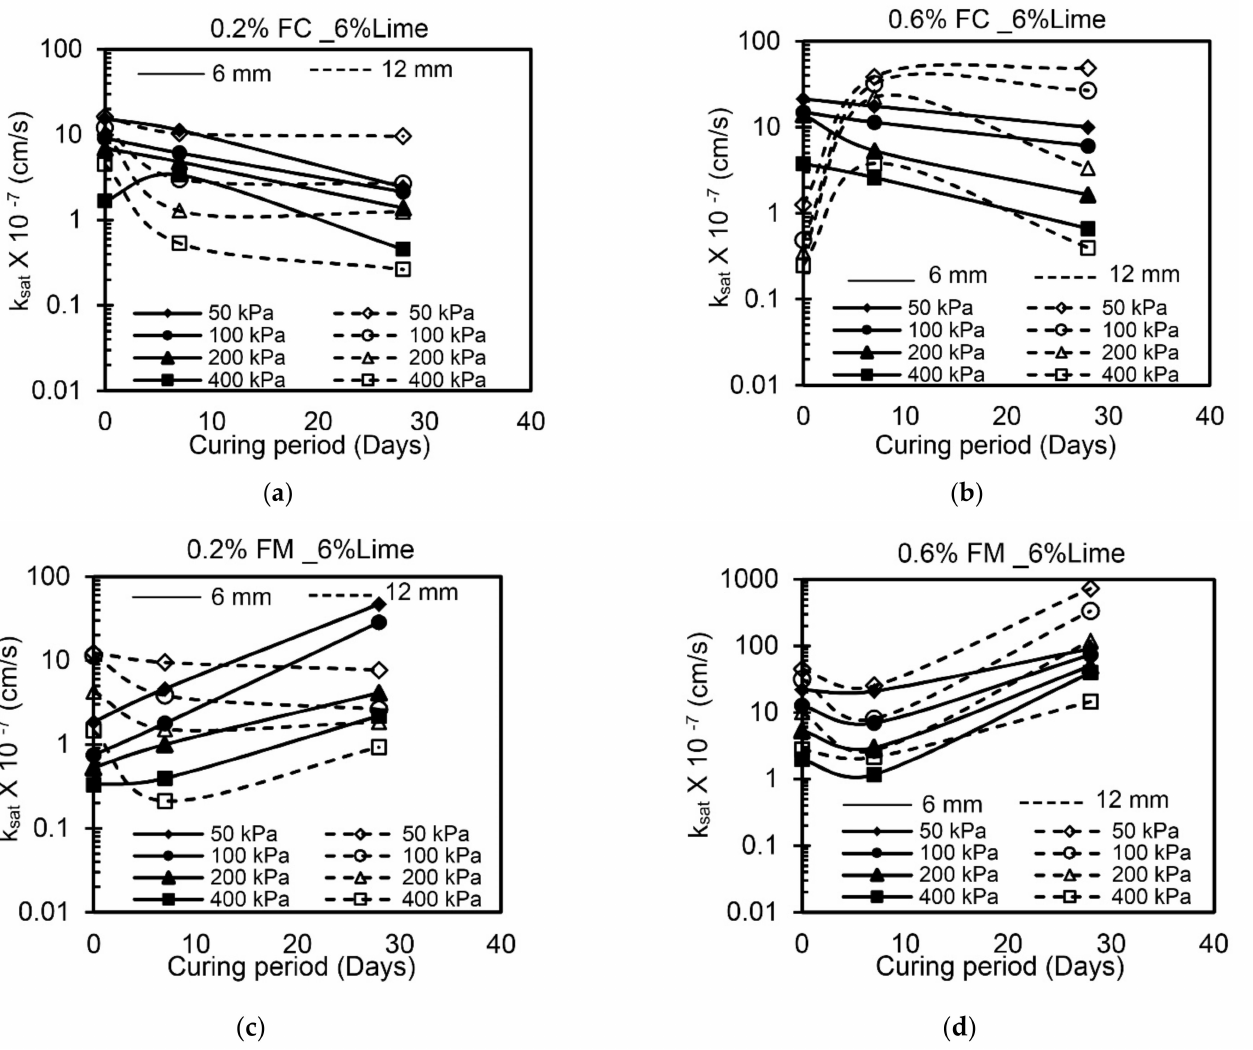
Figure 8. Variation of k sat values with curing period and confining pressure ( a ) FC_0.2% ( b ) FC_0.6% ( c ) FM_0.2% ( d )